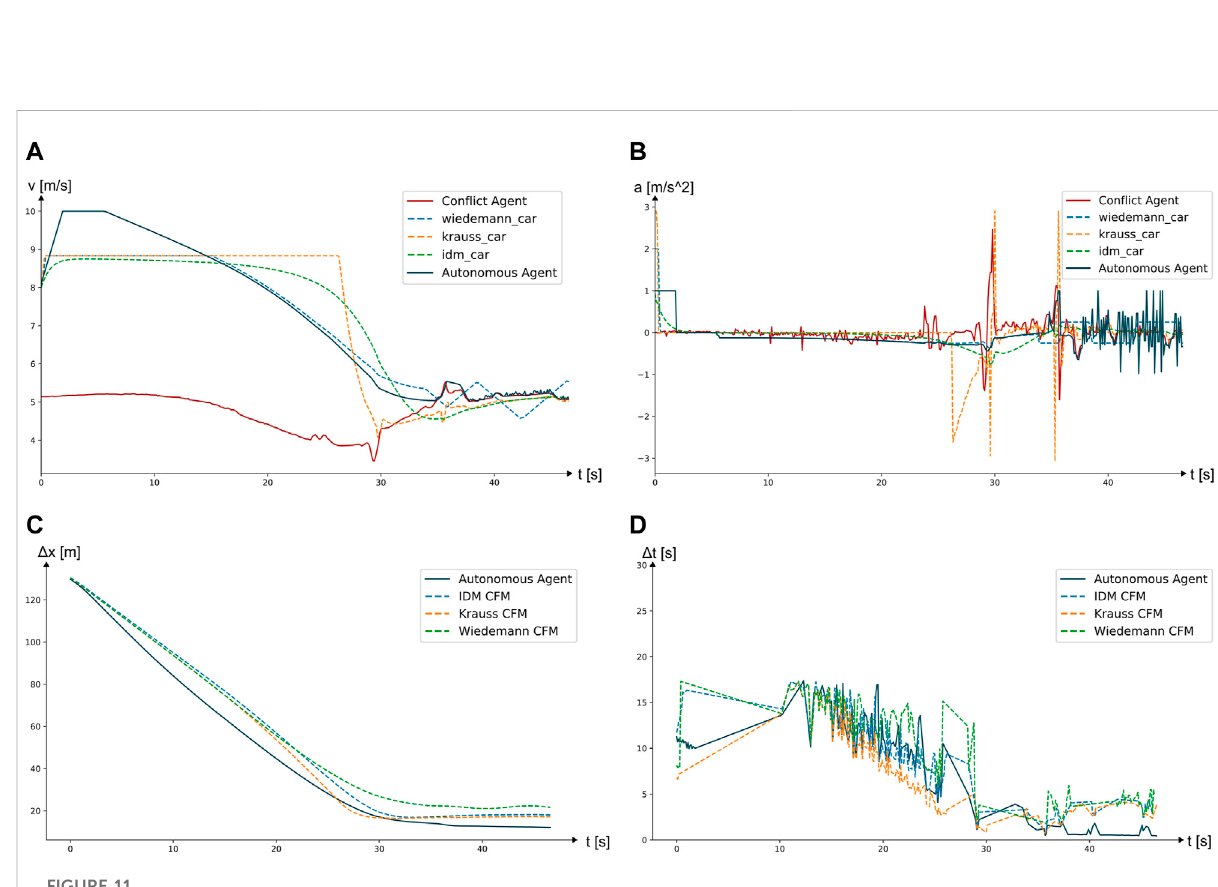
FIGURE 11 (A) Resulting speed pro fi les for scenario 1, (B) resulting acceleration and deceleration pro fi les for scenario 1, (C) showing the distance to the leading agent for scenario 1, (D) showing the difference between the actual TTC and TTC req de fi ned by the given minimum safety distance to the leading agent for scenario